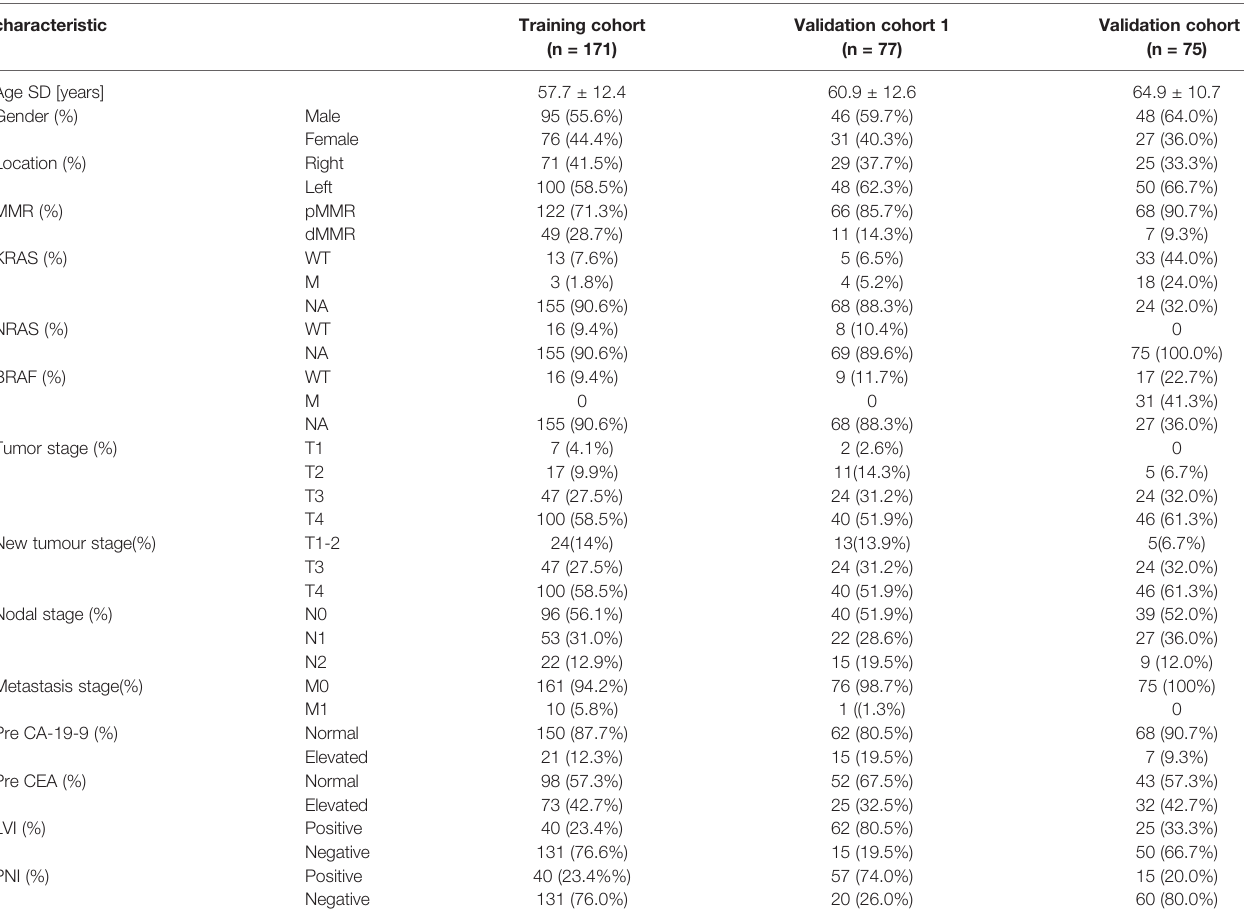
TABLE 1 | Patient